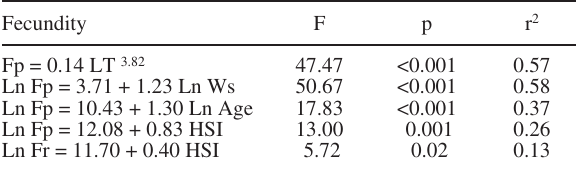
Table 2. – Results of the significant regression analysis for the ef- fects of total length (TL), somatic weight (Ws), age, Le Cren index (K ) and hepatosomatic Index (HSI) on potential (Fp) and relative R (Fr) fecundity of Epinephelus marginatus . Fecundity